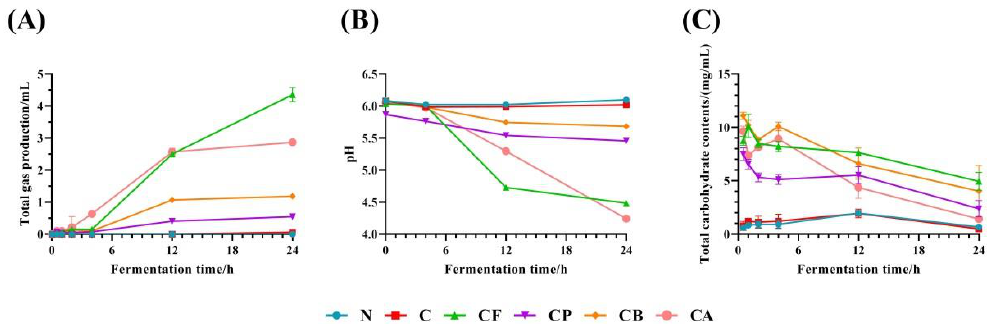
Figure 2. Cumulative gas production ( A ), pH changes ( B ), and total carbohydrate contents ( C ) during in vitro fermentation for C3G and different polysaccharides.